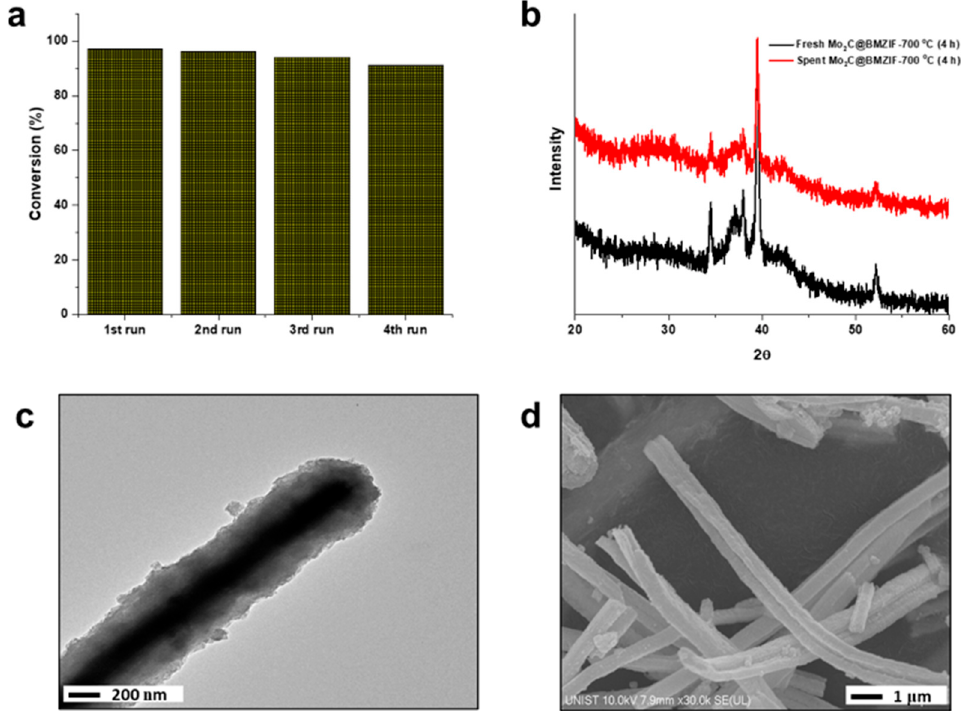
Figure 7. ( a ) Catalytic recyclability test for 4 runs (catalyst 60 mg, guaiacol 0.12 g, n -decane 20 mL, 330 °C, 4 h, 4 MPa), ( b ) XRD, ( c ) TEM, and ( d ) FE-SEM results of the spent Mo 2 C@BMZIF-700 °C (4 h) catalyst after 4 runs.